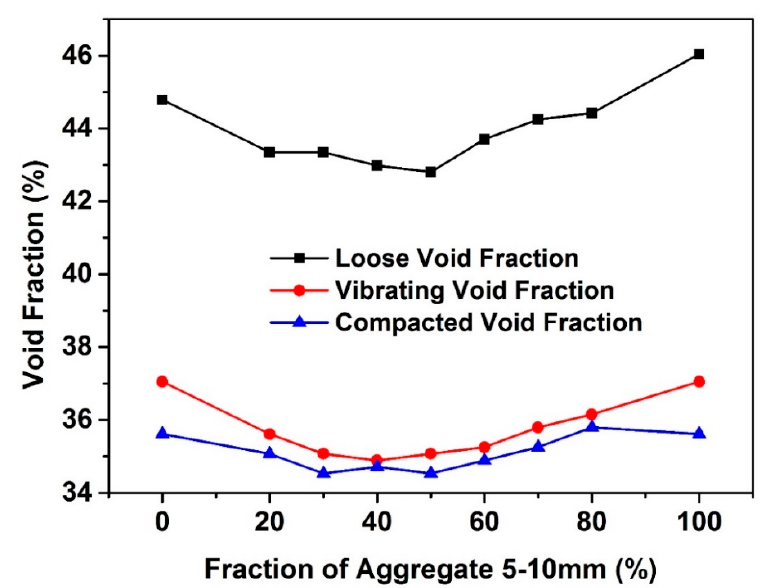
Figure 4. Void fraction as a function of fine gravel volume fraction in coarse-fine gravel mixtures.